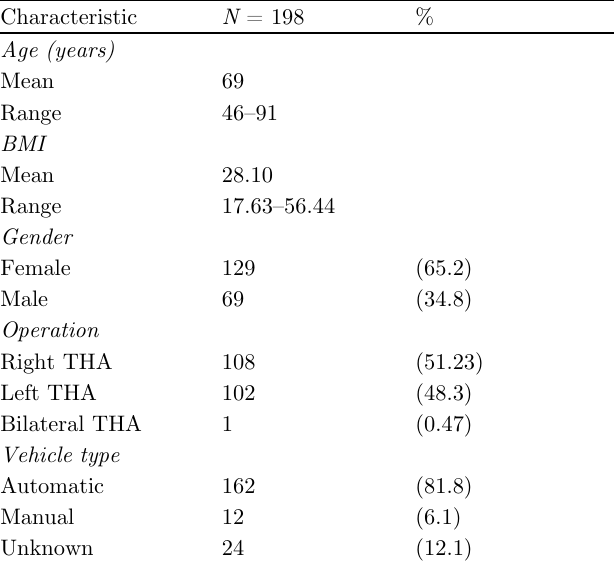
Table 1. Patient demographics.